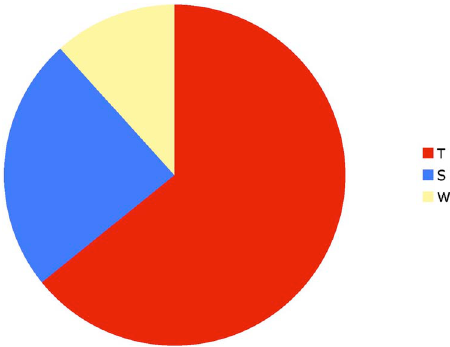
FIG. 1. (cid:1) Color (cid:2) Overall proportions of student-TA interactions that were (cid:1) T (cid:2) TA initiated, (cid:1) S (cid:2) student initiated, and (cid:1) W (cid:2) worksheet initiated.